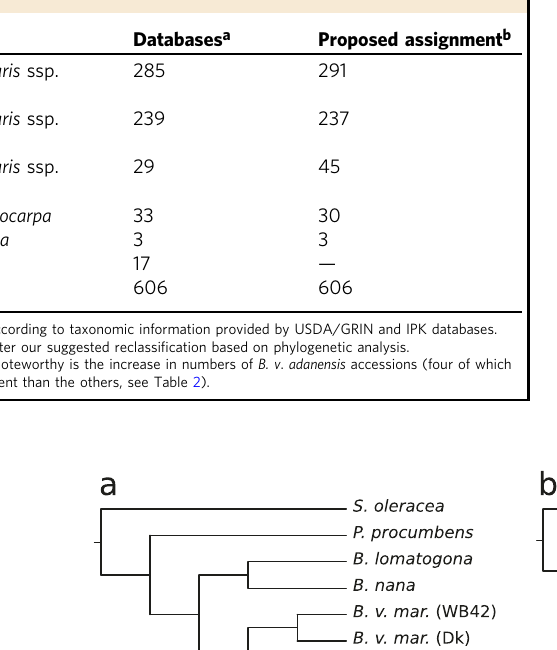
Table 1 Number of accessions per species analysed in this study.